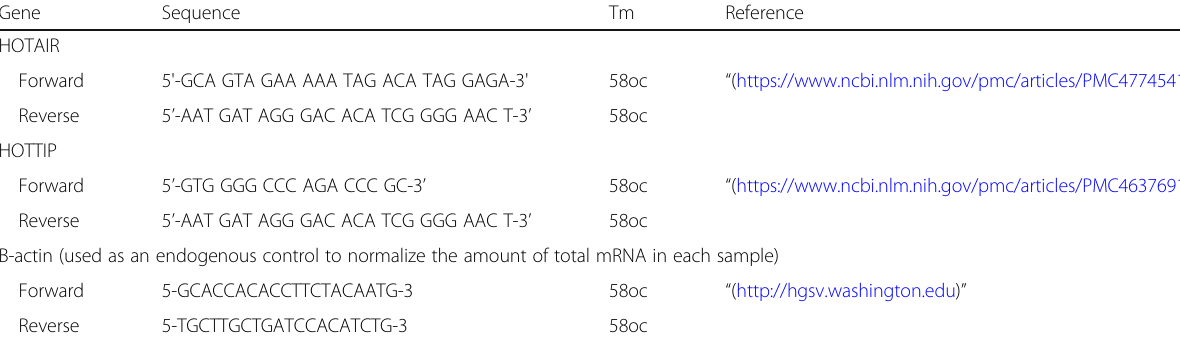
Table 1 Primers of genes included in the